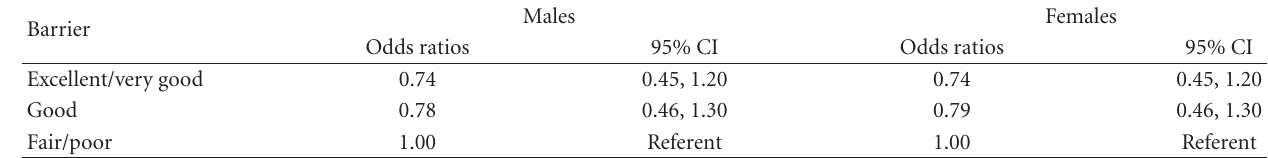
Table 4: Odds of nonparticipation as a function of self-rated general health status.